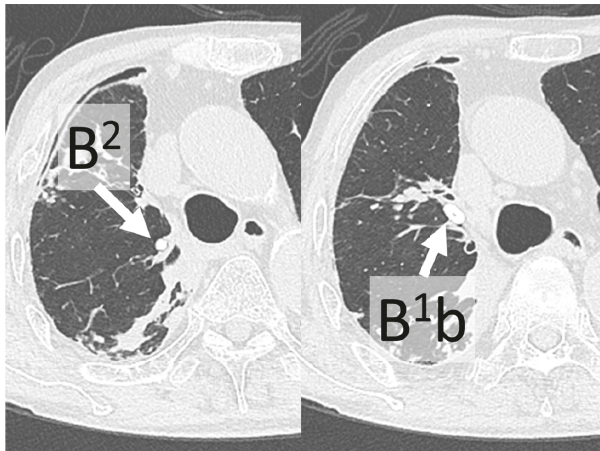
Figure4:Chestcomputedtomographyshowsimprovementofpneumothoraxandpleuraleffusionintherightlung.EndobronchialWatanabe spigots were placed in B 2 and B 1 b of the right